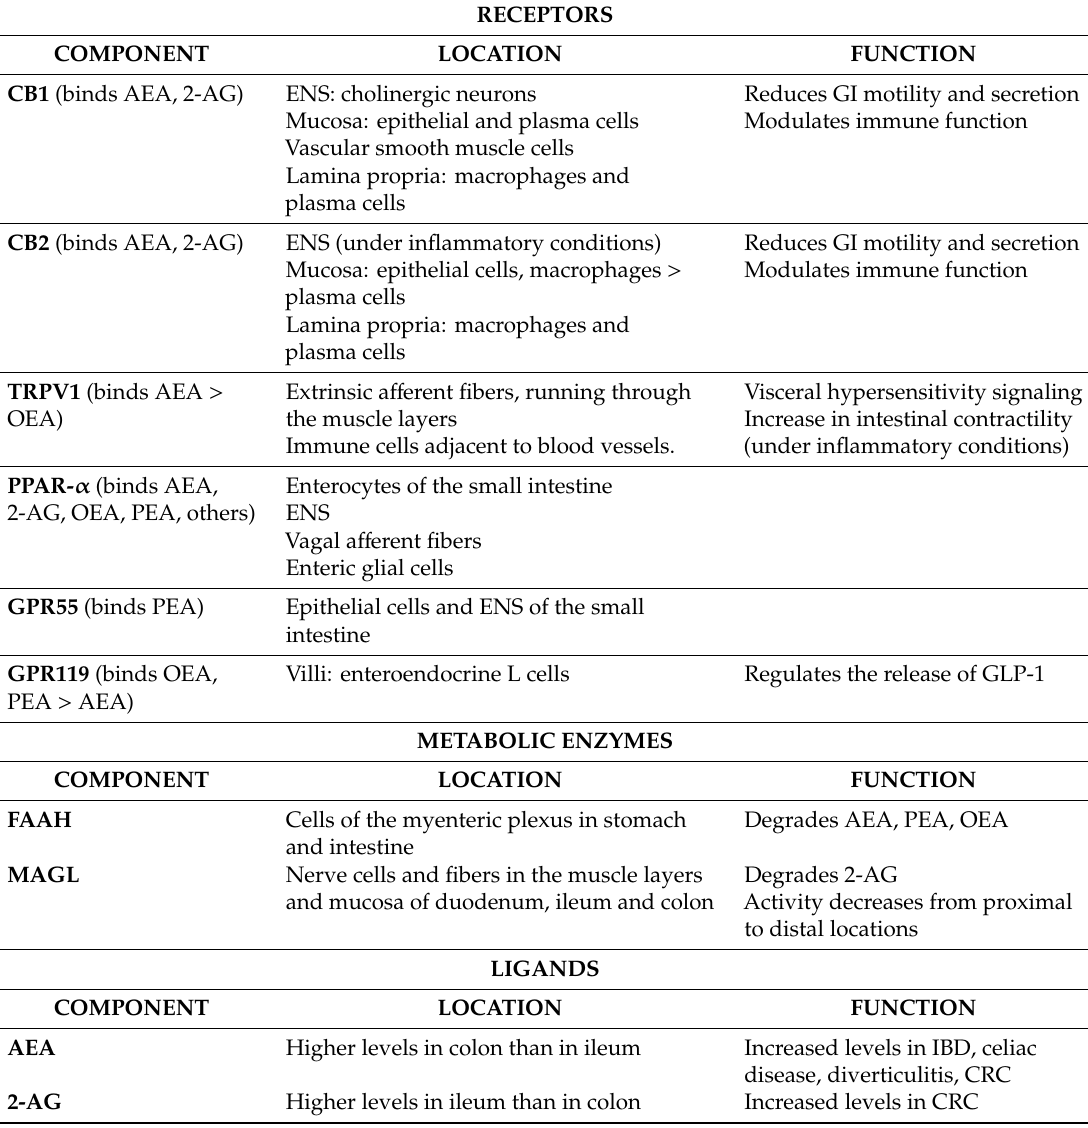
Table 3. Main locations and functions of di ff erent components of the endocannabinoid system (ECS) within the gastrointestinal (GI)